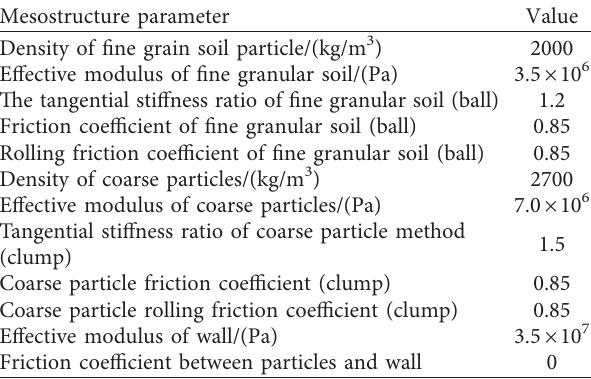
Figure 5: Mesoscopic contact model of numerical sample. (a) Contact between ball-ball and ball-pebble. (b) Contact between ball-facet. Table 2: mesoscopic parameters of DEM contact